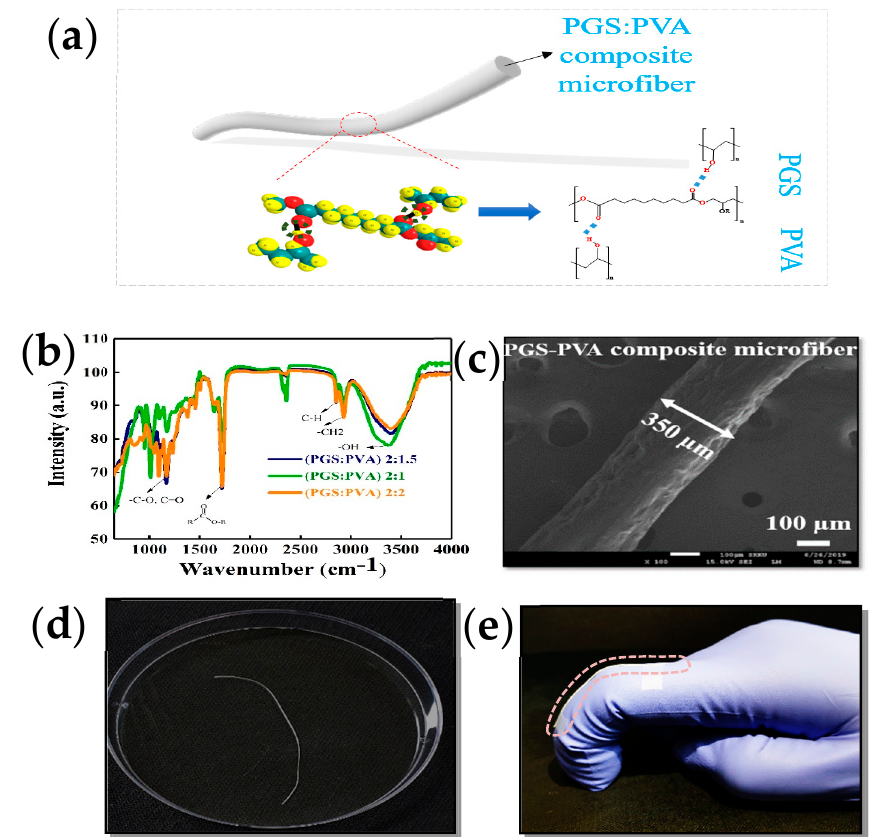
Figure 1. Schematic and characteristics of biodegradable microfiber. ( a ) Representation of PGS:PVA composite microfiber. Hydrogen bonding is shown by the dotted lines between the PGS and PVA in the composite. ( b ) FT-IR spectra of the prepared composite solutions at various ratios of PGS:PVA (2:1, 2:1.5 and 2:2 ( v / v )). ( c ) A cross-sectional FE-SEM image of a microfiber with a diameter of about 350 µm. The scale bar is 10 µm. ( d ) The photograph shows the uniform length of the fabricated microfibers. ( e ) The photograph demonstrates the conformity of the microfiber to a human finger.